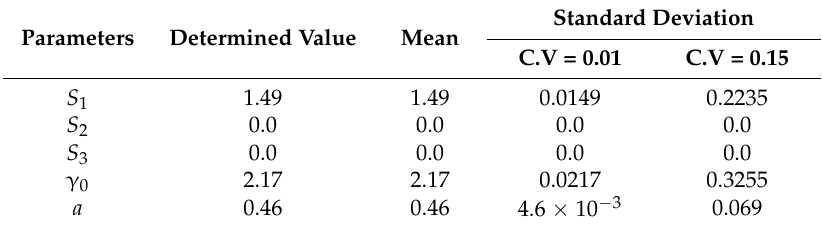
Table 2. The values of Mie-Grüneisen equation of state parameters for steel in example